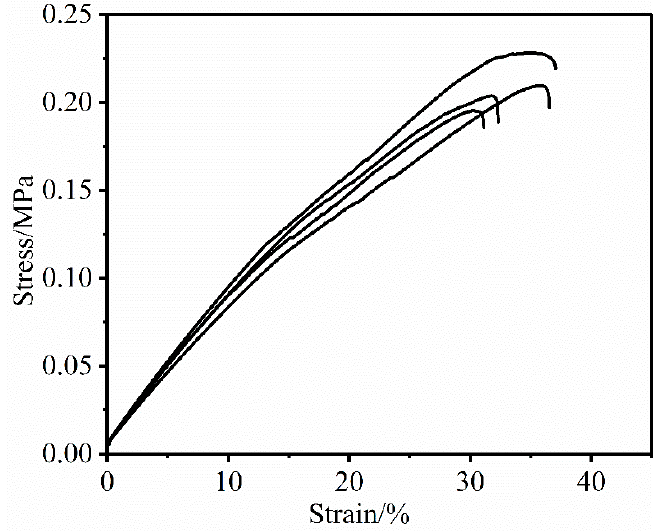
Figure 10. Stress-strain curves of PTPET (including Bu-NENA) with GAP ( Mn = 4000 g/mol).